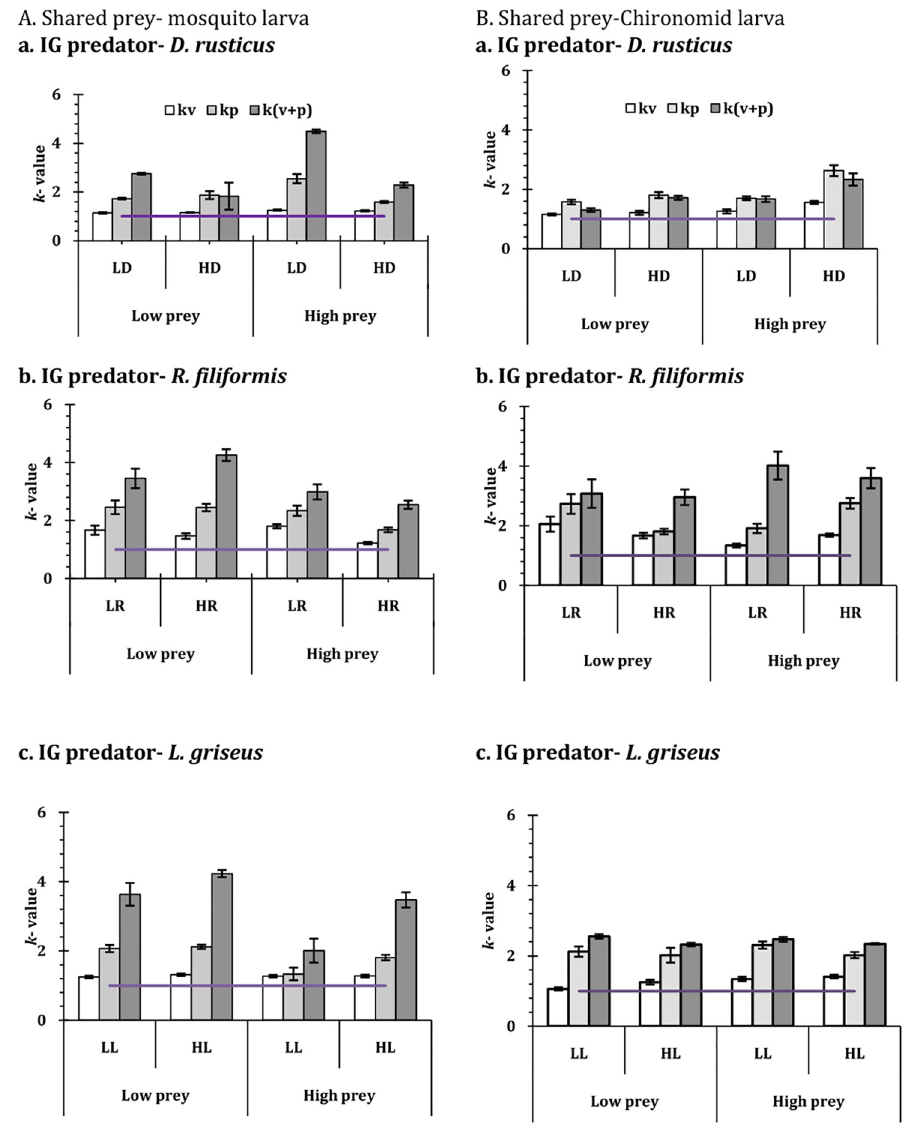
Fig 5. Mortality of shared prey ( A—mosquito larvae, B- chironomid larvae ) in IGP system in complex habitat conditions (v–vegetation, p–pebbles and v+p—vegetation and pebbles) against simple conditions expressed as a ratio ( k– value, mean ± SE) for the three IG predators in two density (L– 2 individuals and H—4 individuals) under low and (50 individuals) high (200 individuals) prey density. The horizontal lines in each graph represents the reference value of 1, equivalent to the value of no difference between the complex habitat condition and open